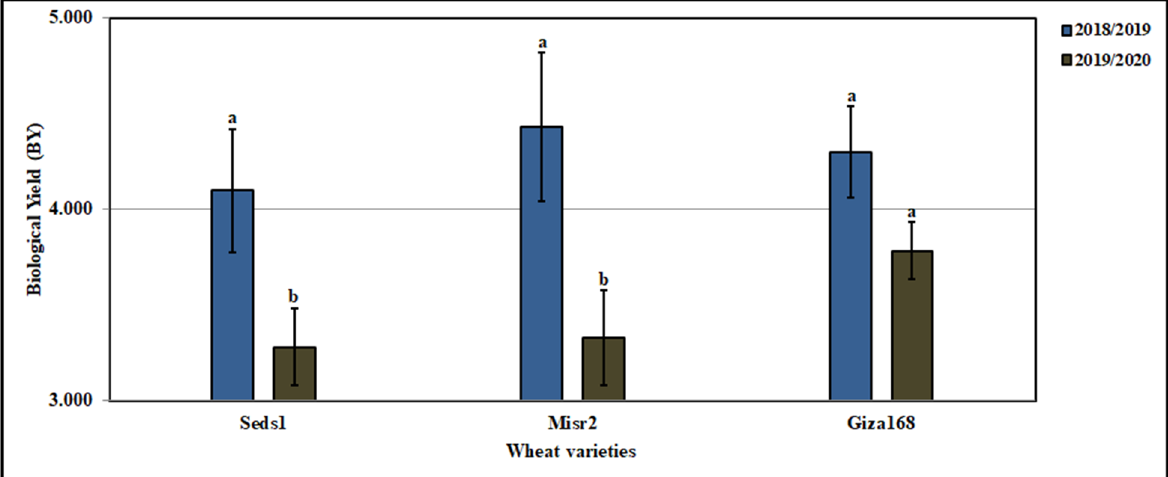
Figure 17. Influence of wheat varieties on biological yield (BY, kg) in clay loam soil in 2018/2019 and 2019/2020 seasons. Bars in the same years with a different letter indicate significant differences between treatments at p ≤ 0.01. HS 1, HS 2 , HS 3 represent HS applied as foliar spray at 1.0, 2.0, 4.0 g L − 1 , respectively, HS 4 , HS 5 , HS 6 represent HS applied as soil application at 5.04, 7.56, 10.08 kg ha − 1 .